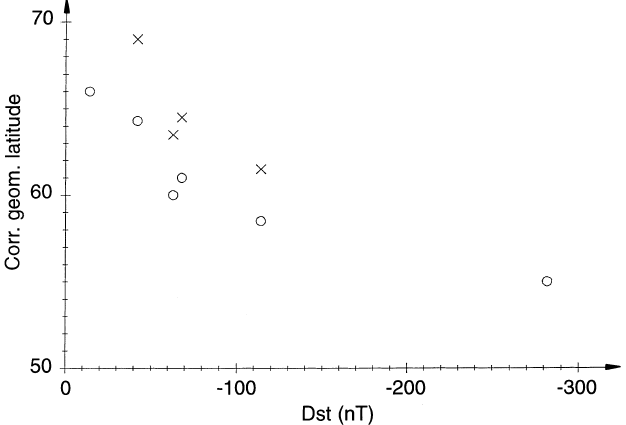
Fig. 3. The position of the eastward electrojet center ( circles ) and Harang discontinuity ( crosses ) at 17-18 MLT during magnetic storms on February 05–07, 1994 and May 10, 1992